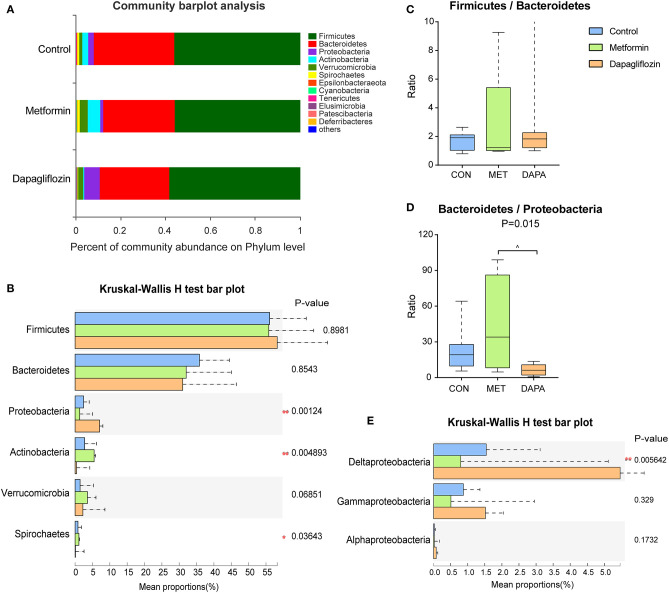
Characterization of core microbial communities. (A) Community barplot analysis showing the relative abundance on the phylum level. (B)
Firmicutes to Bacteroidetes ratio. (C) Relative abundance of the domain phyla Firmicutes, Bacteroidetes, Proteobacteria, Actinobacteria, Verrucomicrobia, and Spirochaetes. (D) Ratio of Bacteroidetes to Proteobacteria. Kruskal-Wallis rank-sum test was used to assess the ratio of Firmicutes to Bacteroidetes and the ratio of Bacteroidetes to Proteobacteria. (E) Relative abundance of Proteobacteria (delta, gamma, and alpha). *P < 0.05, **P ≤ 0.01, ^metformin versus dapagliflozin P < 0.05.